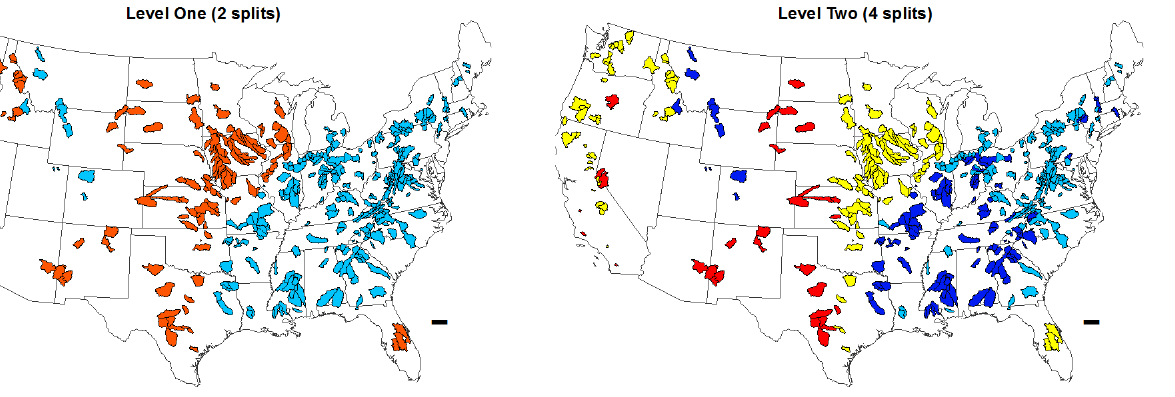
Fig. 7. First split, low seasonality (blue) and higher seasonality (or- ange).